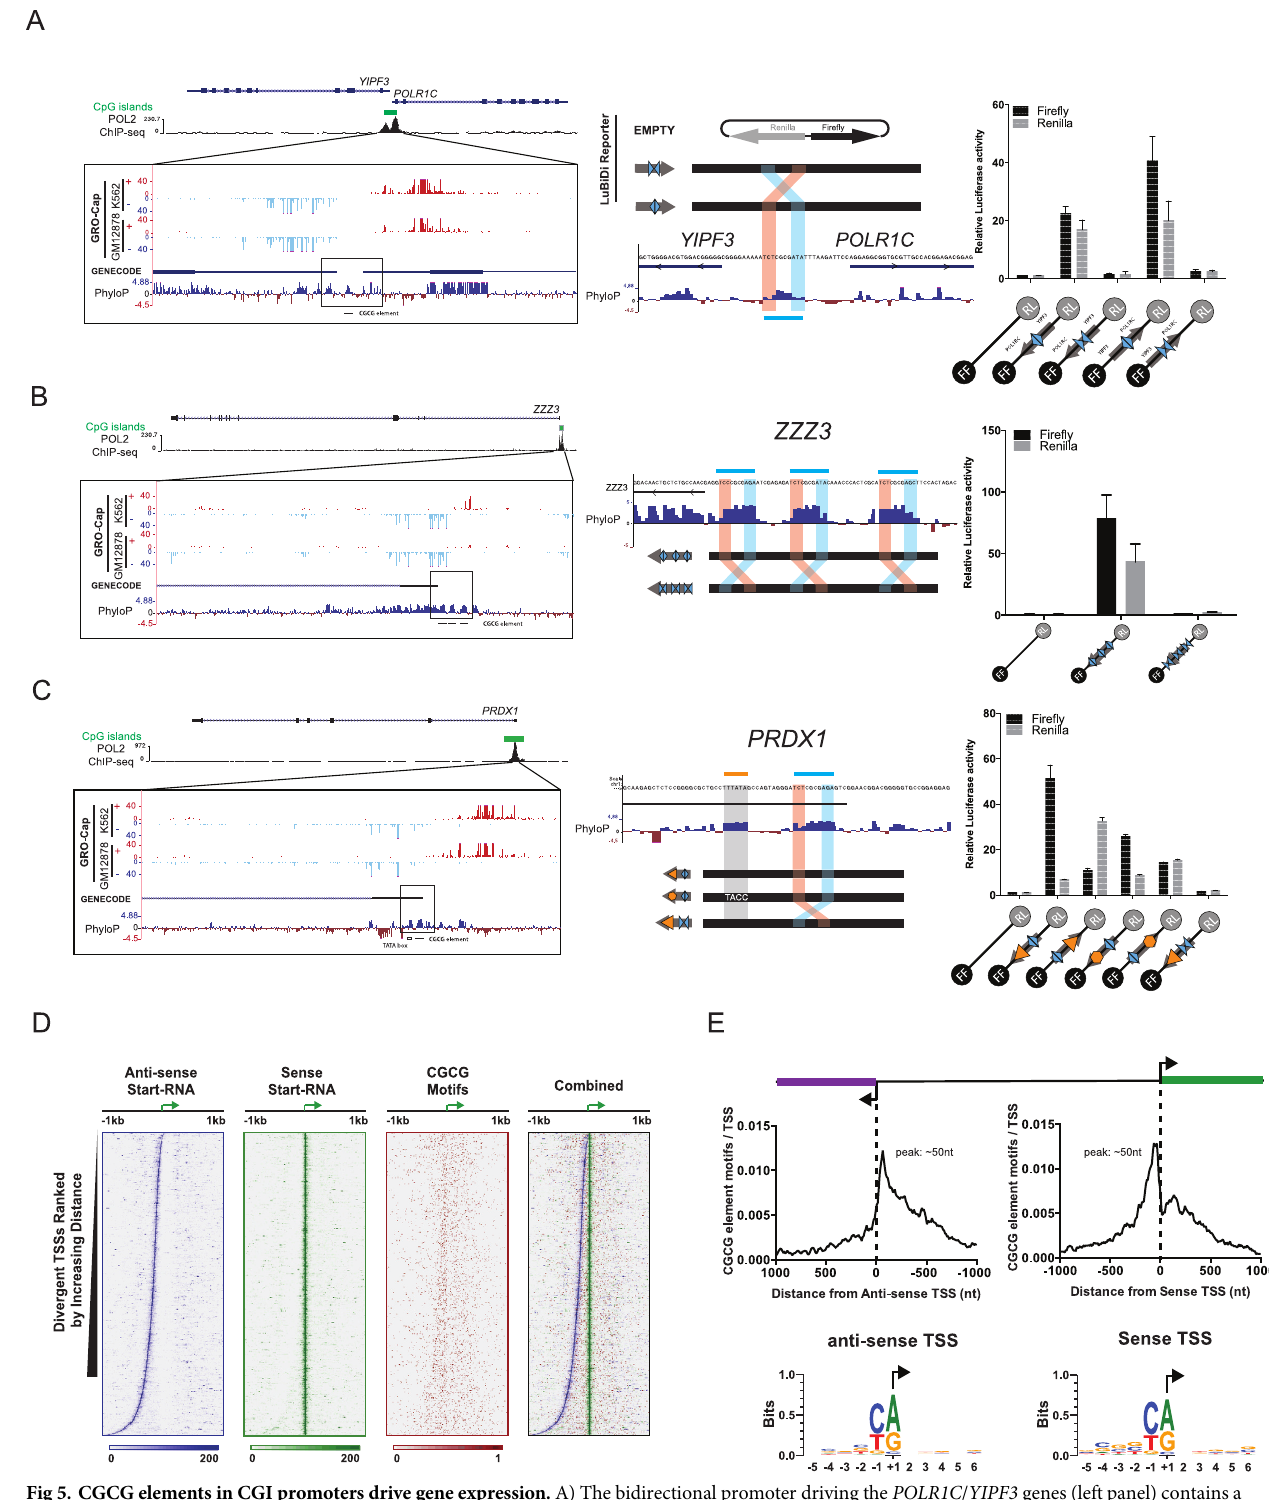
Fig 5. CGCG elements in CGI promoters drive gene expression. A) The bidirectional promoter driving the POLR1C / YIPF3 genes (left panel) contains a conserved CGCG element between annotated TSSs (middle), which was cloned and tested for bidirectional promoter activity in LuBiDi. Right panel- the promoter insert orientation is defined by a large grey arrow, with the WT CGCG element flank orientation represented by ^ , and the flank-exchanged variants represented by ⊳⊲ . B) The ZZZ3 promoter contains three CGCG elements. Although this promoter is annotated as unidirectional, the